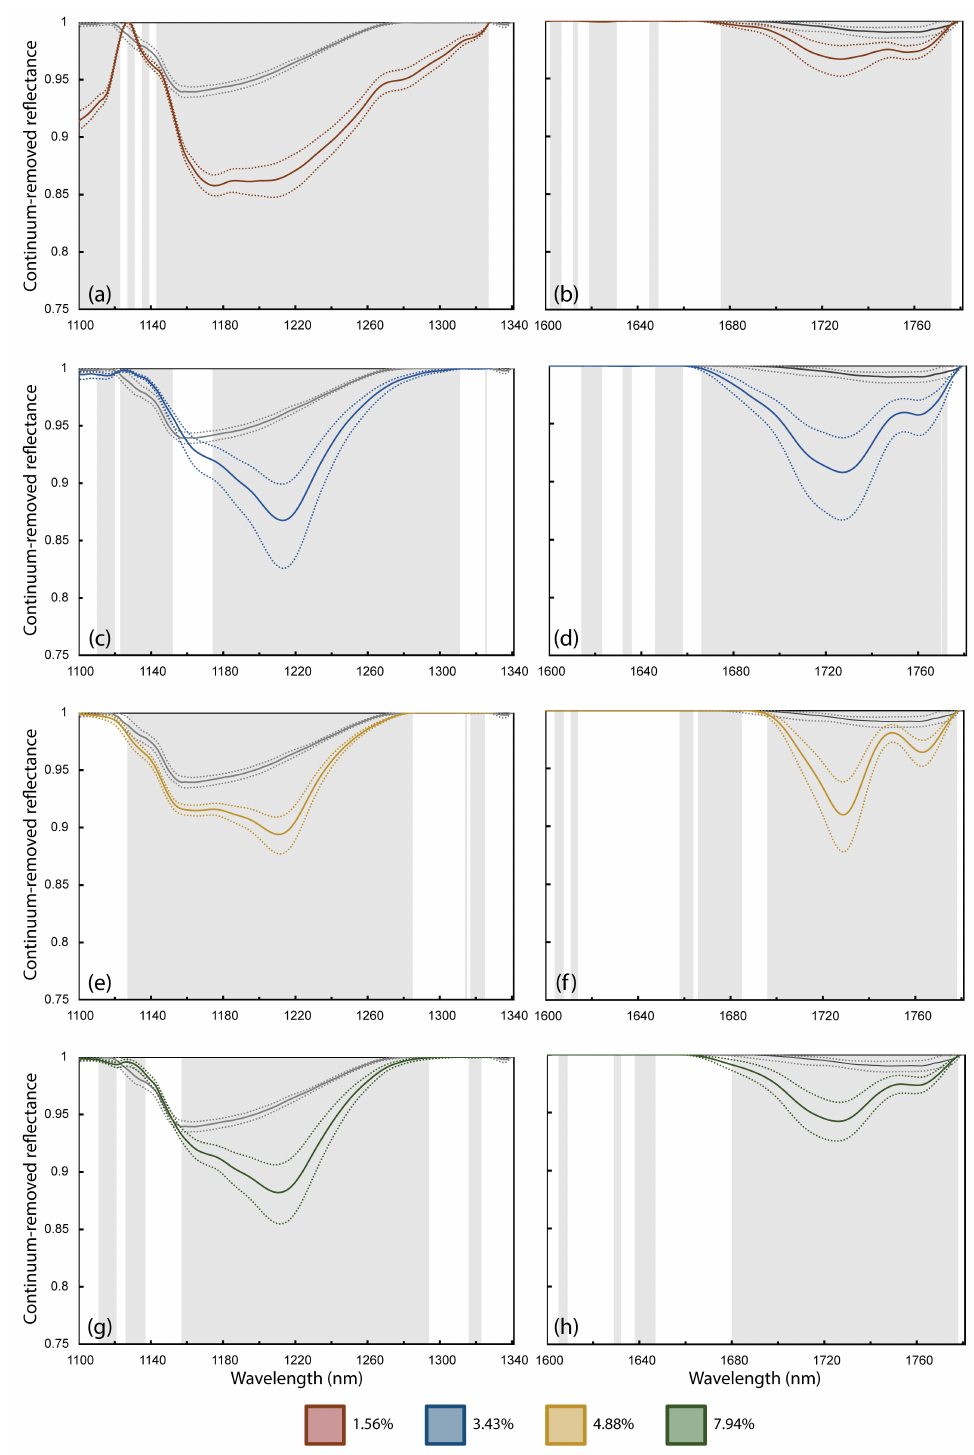
Figure 7. Continuum-removed reflectance of quadrats that had statistically significant differences in spectra when compared to a control sand group. The mean and 95% upper and lower confidence intervals are shown for both sand-only spectra (dark tones) and the MPD contaminated quadrat (in colour). Statistically significant differences are shaded in grey. Quadrats exhibited surface covers of ( a ) 1.56% at 1215 nm and ( b ) 1732 nm, ( c ) 3.43% at 1215 nm and ( d ) 1732 nm ( e ) 4.88% at 1215 nm and ( f ) 1732 nm and ( g ) 7.94% at 1215 nm and ( h ) 1732